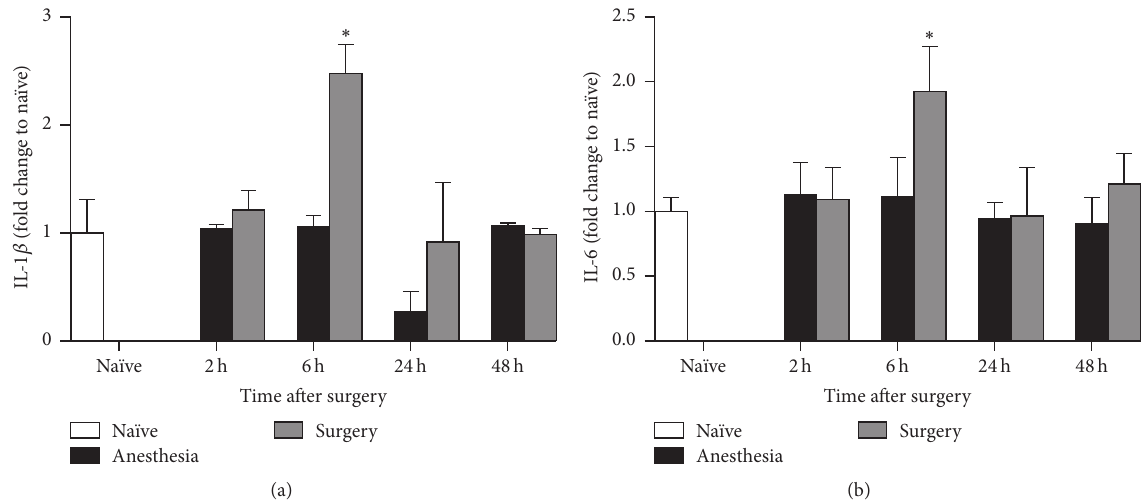
Figure 2: IL-1 𝛽 and IL-6 levels in the hippocampus. Six hours after surgery, the hippocampal IL-1 𝛽 and IL-6 levels increased significantly compared with those in the na¨ıve group ( 𝑝 < 0.05 ). No significant differences were observed at other time points. ∗ 𝑝 < 0.05 compared with the na¨ıve group. For IL-1 𝛽 , 𝑛 = 9 in na¨ıve group; 𝑛 = 4 in 2 h, 6h, and 48h; 𝑛 = 6 in 24 h for the anesthesia group. For IL-6, 𝑛 = 10 in na¨ıve group; 𝑛 = 4 in 2 h, 6 h, and 48h; 𝑛 = 5 in 24 h for the surgery group.